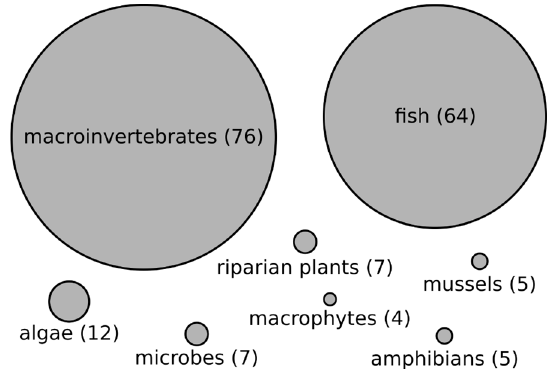
Figure 4. Types of organisms assessed in studies inferring biodiversity–stream size relationships.